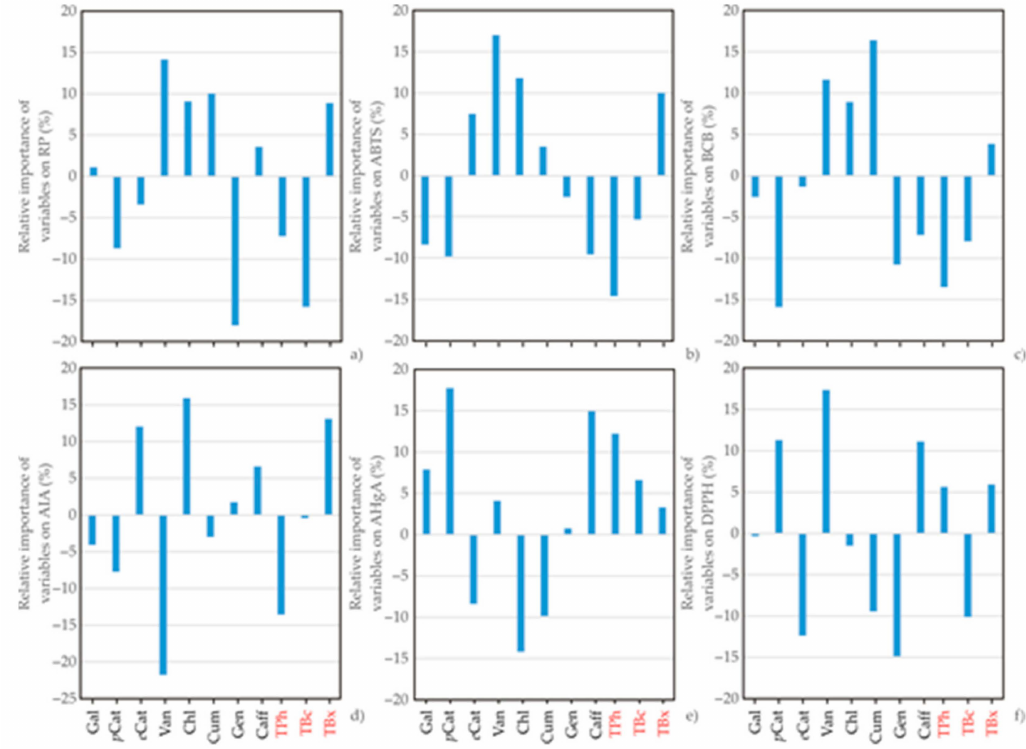
Figure 4. The relative importance of Gal, p Cat, e Cat, Van, Chl, Cum, Gen and Caff, and also TPh, TBc and TBx on ( a ) RP, ( b ) ABTS, ( c ) BCB, ( d ) AIA, ( e ) AHgA and ( f ) DPPH, determined using the Yoon interpretation